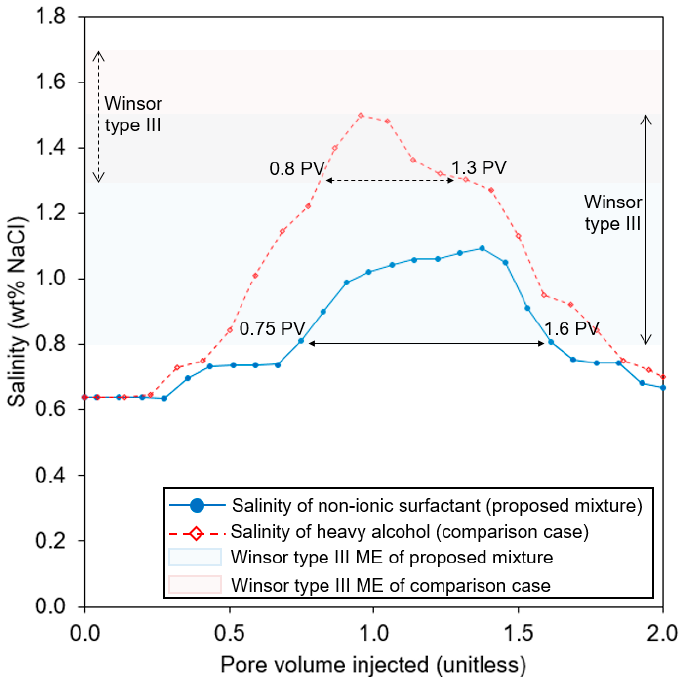
Figure 8. Plot of the effluent salinity and cumulative oil recovery versus pore volumes to investigate the importance of the type III occurrence. ‘ME’ stands for